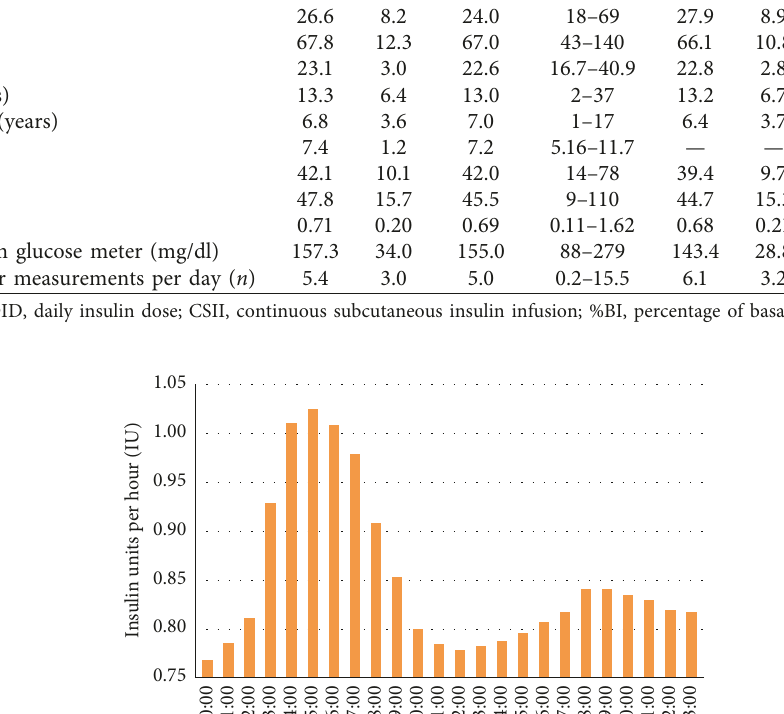
Table 1: Study group characteristics and the comparison between T1DM patients with in-target HbA1c and above-target HbA1c are shown. Variables